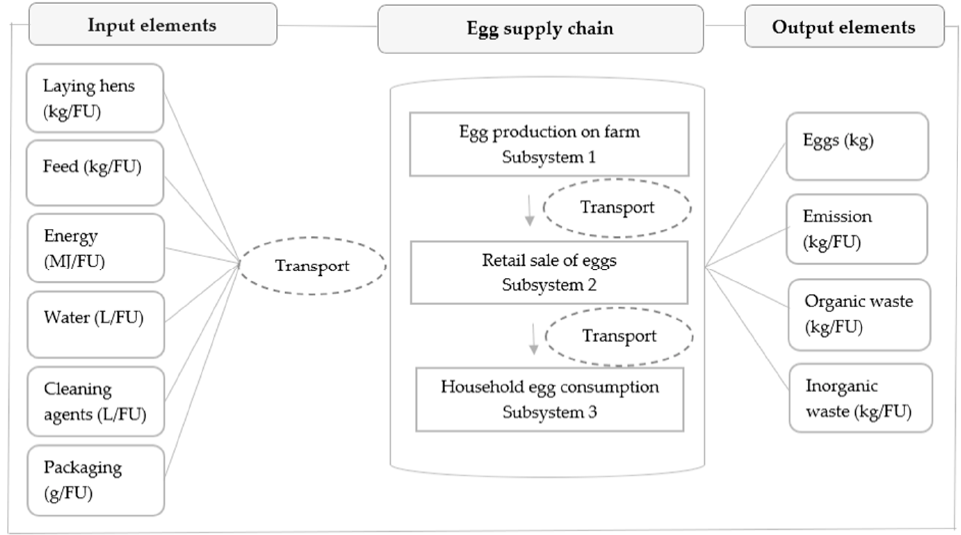
Figure 1. System boundaries of the egg production life cycle and material flow analysis; FU—Functional unit (1 kg of eggs).